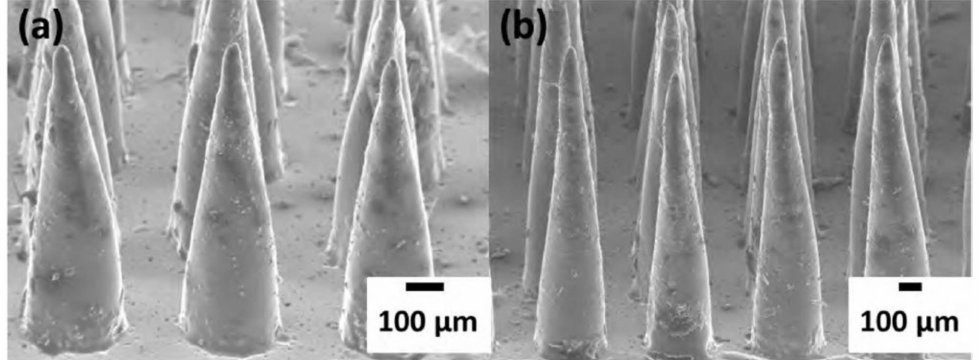
Figure 8. SEM micrographs of the cast PDMS microneedles array from the PMMA mold ablated at laser powers of: ( a ) 3 W and ( b ) 10 W at a constant 114 mm s − 1